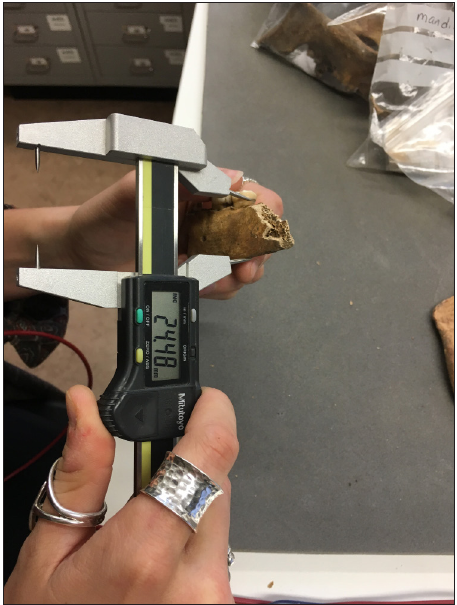
Figure 1: A MSc Bioarchaeological and Forensic Anthropology student collecting metric data from the mandibular dentition of an individual from Chichester (Photo Carolyn